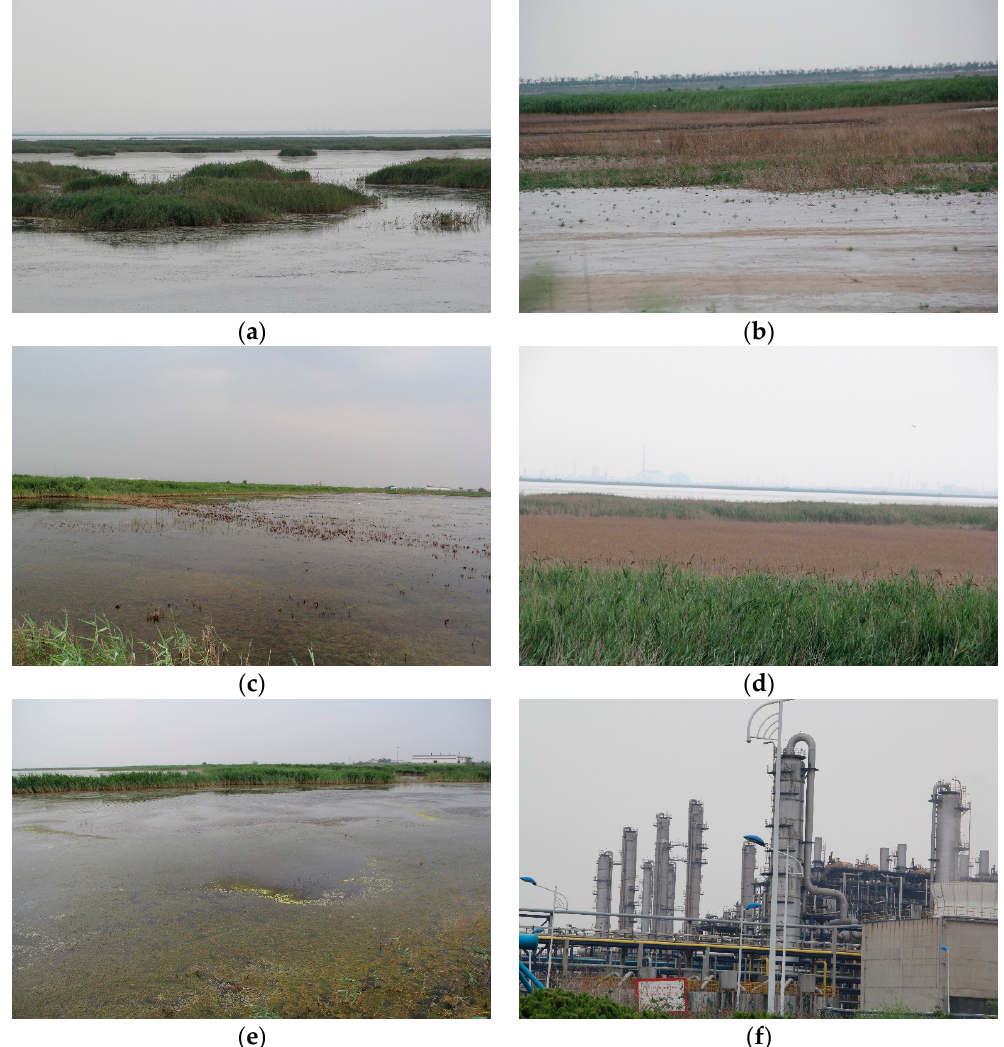
Figure 2. ( a – f ) The field observations on 27 June 2016; a through e correspond to some photos of different vegetation types and f is the oil finery which corresponds to region C (in the red circle) in Figure 1c. The entire flowchart of the study is given in Figure